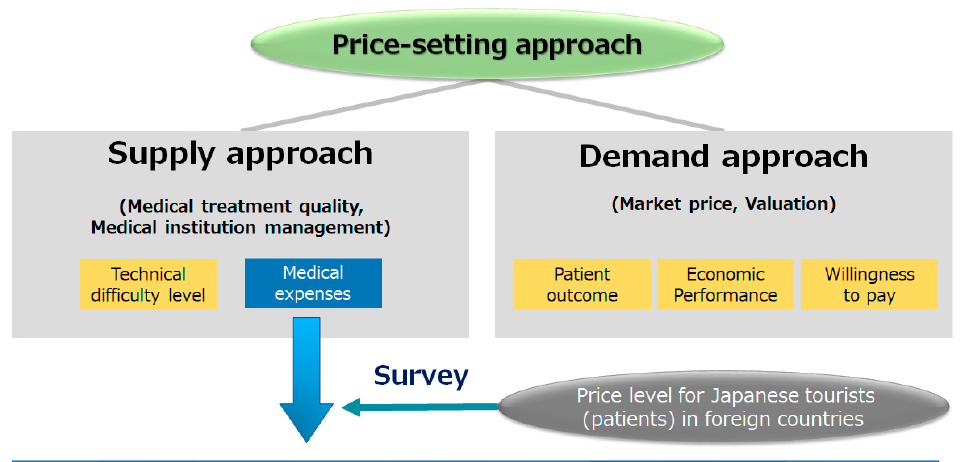
Figure 1. Theory of the price-setting approach (in general and within the range of this examina-